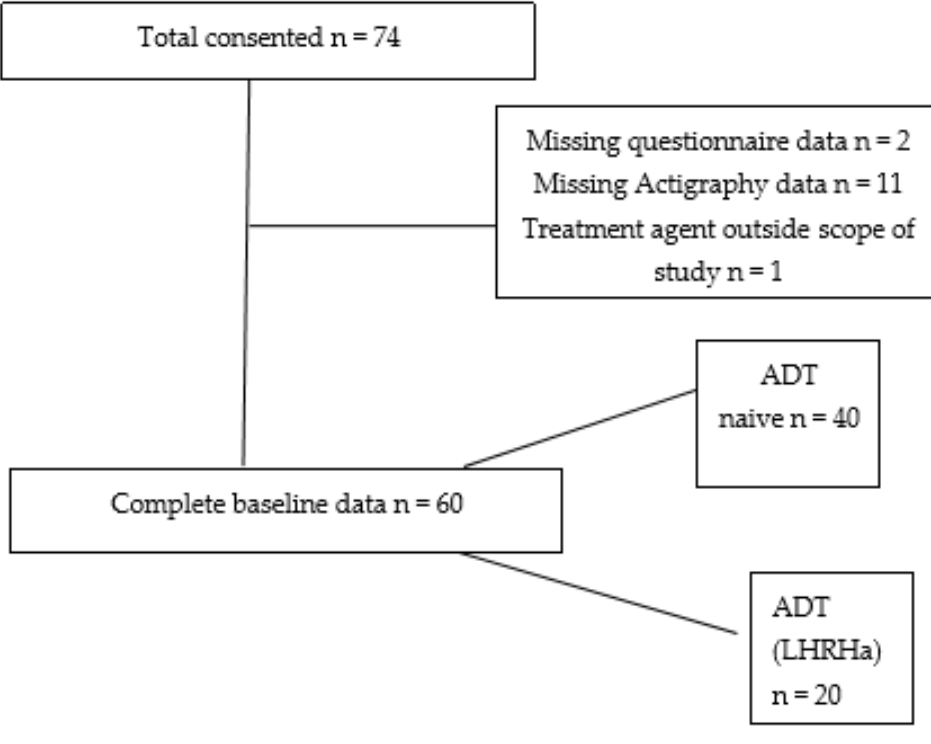
Figure 1. Consort diagram of patient data collection and assessment.